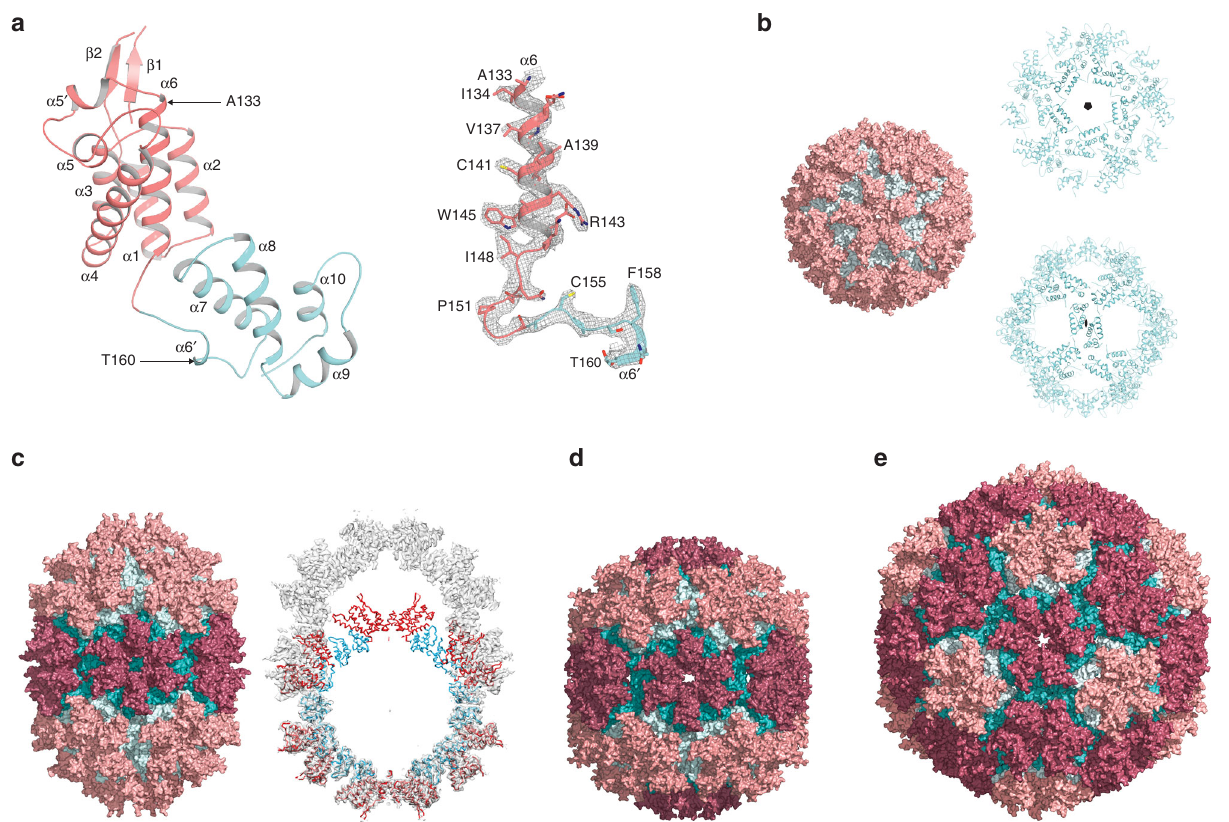
Fig. 2 Structure of HML2 CA rec monomer and assembled particles. a (Left) Cartoon representation of the HML2 CA rec monomer from the T = 1 particle. The CA rec -NTD, residues P1 to S153, and CA rec -CTD, residues A154 to Q246, are coloured in pink and cyan, respectively. (Right) Experimental electron potential map (grey mesh) and model for the region indicated between α 6 and α 6 ′ . Residues G152 to P156 in the linker region were built de novo into the density. b (Left) Surface representation of the T = 1 particle (60 monomers arranged as 12 pentamers) viewed along the fi ve-fold symmetry axis with the NTDs and CTDs coloured as in a . (Right) The inner CTD “ cage ” viewed along the fi ve-fold (upper) and the two-fold (lower). c (Left) D5 particle (90 monomers arranged as 12 pentamers and 5 hexamers) viewed along an equatorial pseudo-hexamer at the two-fold symmetry axis. Pentamer NTDs and CTDs are coloured as in a , and hexamer NTDs and CTDs are coloured in red and teal, respectively. (Right) Central slab of the D5 density map (grey surface) with the T = 1 particle aligned on the D5 polar pentamer. d D6 particle (108 monomers arranged as 12 pentamers and 8 hexamers) viewed along an equatorial pseudo-hexamer at the two-fold symmetry axis. Pentamers and hexamers are coloured as in c . e T = 3 particle (180 monomers arranged as 12 pentamers and 20 hexamers) viewed along an icosahedral two-fold symmetry axis. Pentamers and hexamers are coloured as in c